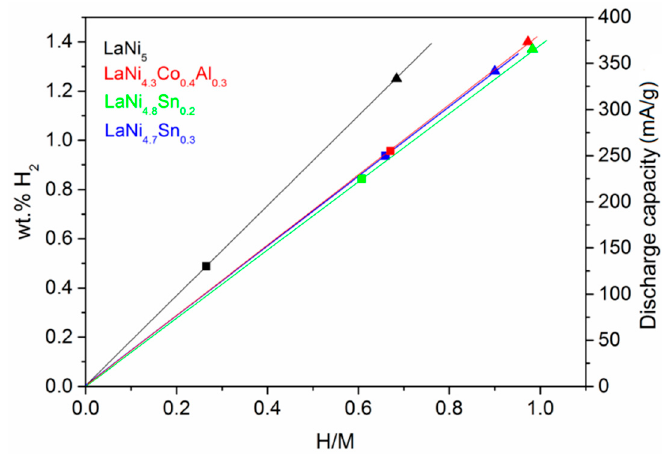
Figure 6. Hydrogen capacity as a function of the hydrogen content of the different alloys. The points correspond to the maximum alloys capacities measured by the two techniques—an electrochemical ( in the corresponding color) and a hydrogen gas phase ( ▲ ).